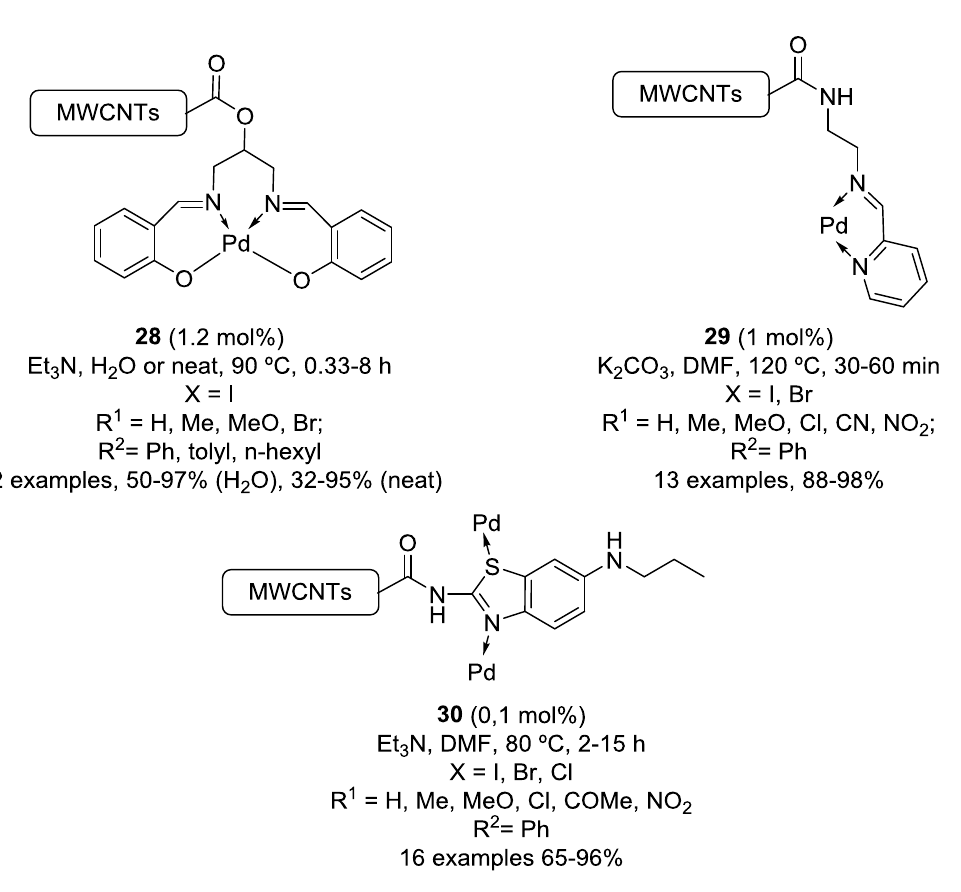
Figure 10. Palladium species on functionalized multi-walled carbon nanotubes as catalysts for the Sonogashira reaction. Conditions, substrate scope and yield range (Scheme 2).